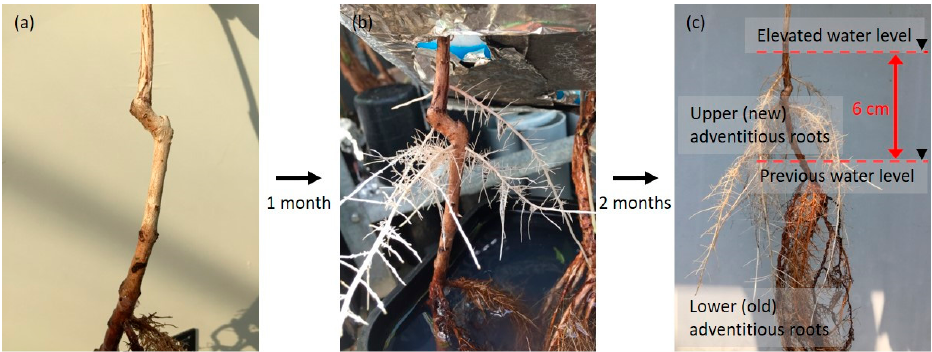
Figure 8. The treatment of the water level elevation, and the development of adventitious roots in